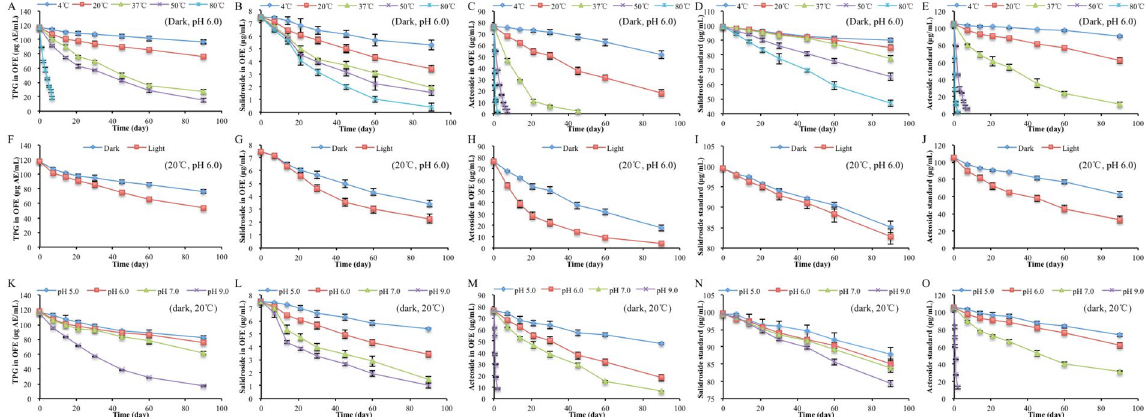
Figure 1. Degradation of phenylethanoid glycosides under different conditions. The effect of temperature on the contents of TPG in OFE ( A ), salidroside in OFE ( B ), acteoside in OFE ( C ), salidroside standard ( D ) and acteoside standard ( E ) at pH 6.0 in the dark; the effect of light on the contents of TPG in OFE ( F ), salidroside in OFE ( G ), acteoside in OFE ( H ), salidroside standard ( I ) and acteoside standard ( J ) at pH 6.0 at 20 °C; the effect of pH on the contents of TPG in OFE ( K ), salidroside in OFE ( L ), acteoside in OFE ( M ), salidroside standard ( N ) and acteoside standard ( O ) at 20 °C in the dark. TPG, total phenylethanoid glycoside; OFE, O. fragrans var. thunbergii flower